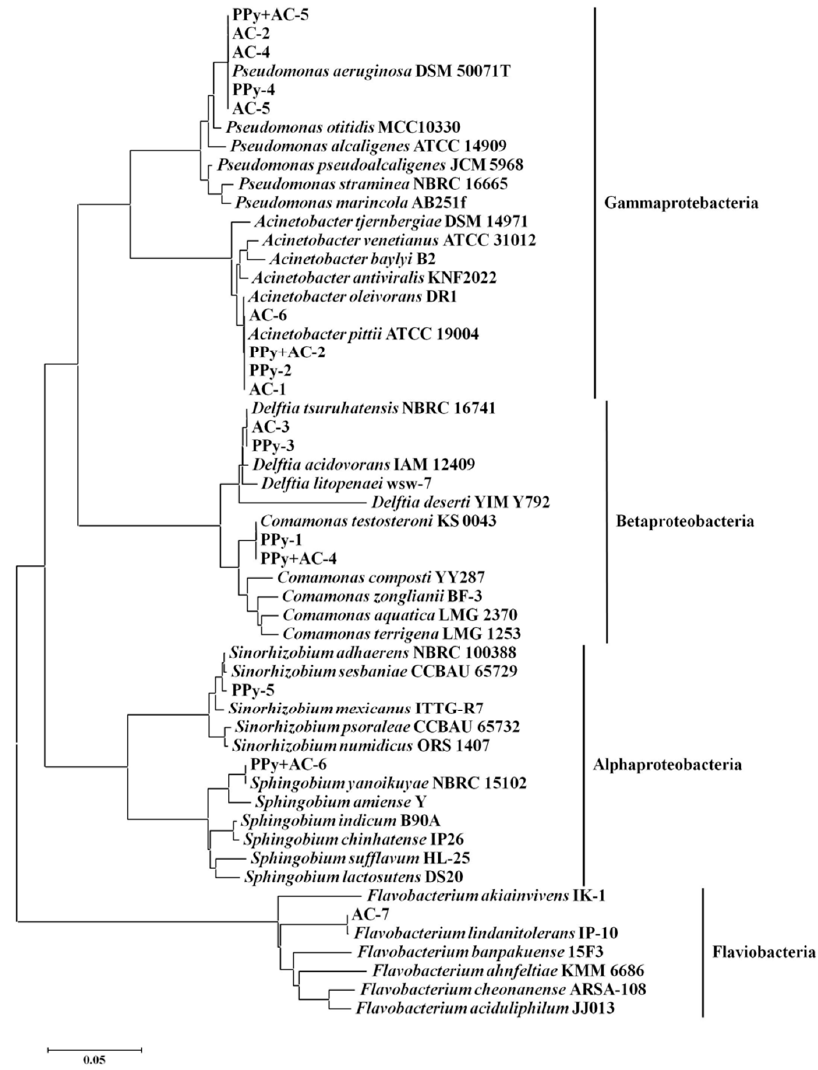
Figure 8. Phylogenetic tree of the bacteria recovered from the different biofilm columns.